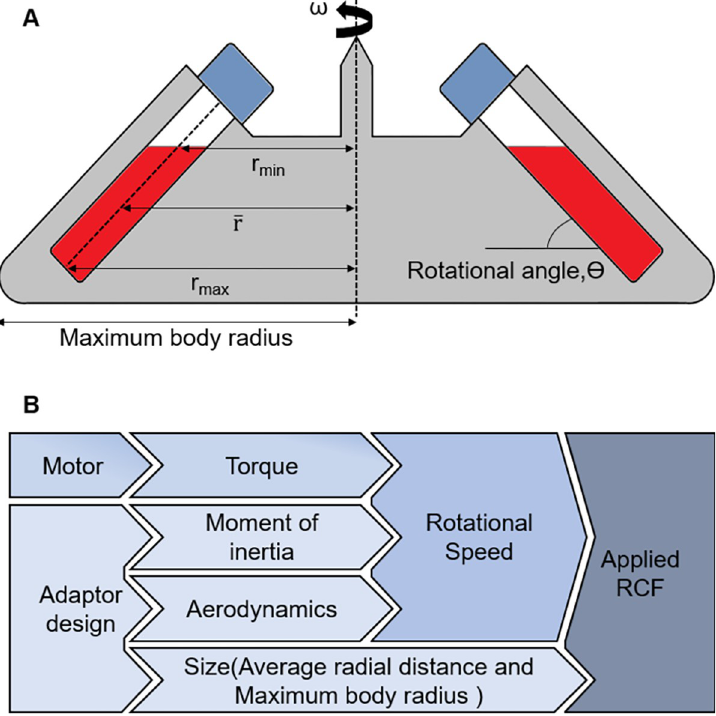
Fig 2. (A) Schematic illustration of the tubes on a fixed-angle adaptor and the radial dimensions (B) The influential parameters on the applied RCF on the sample in the tube mounted on the